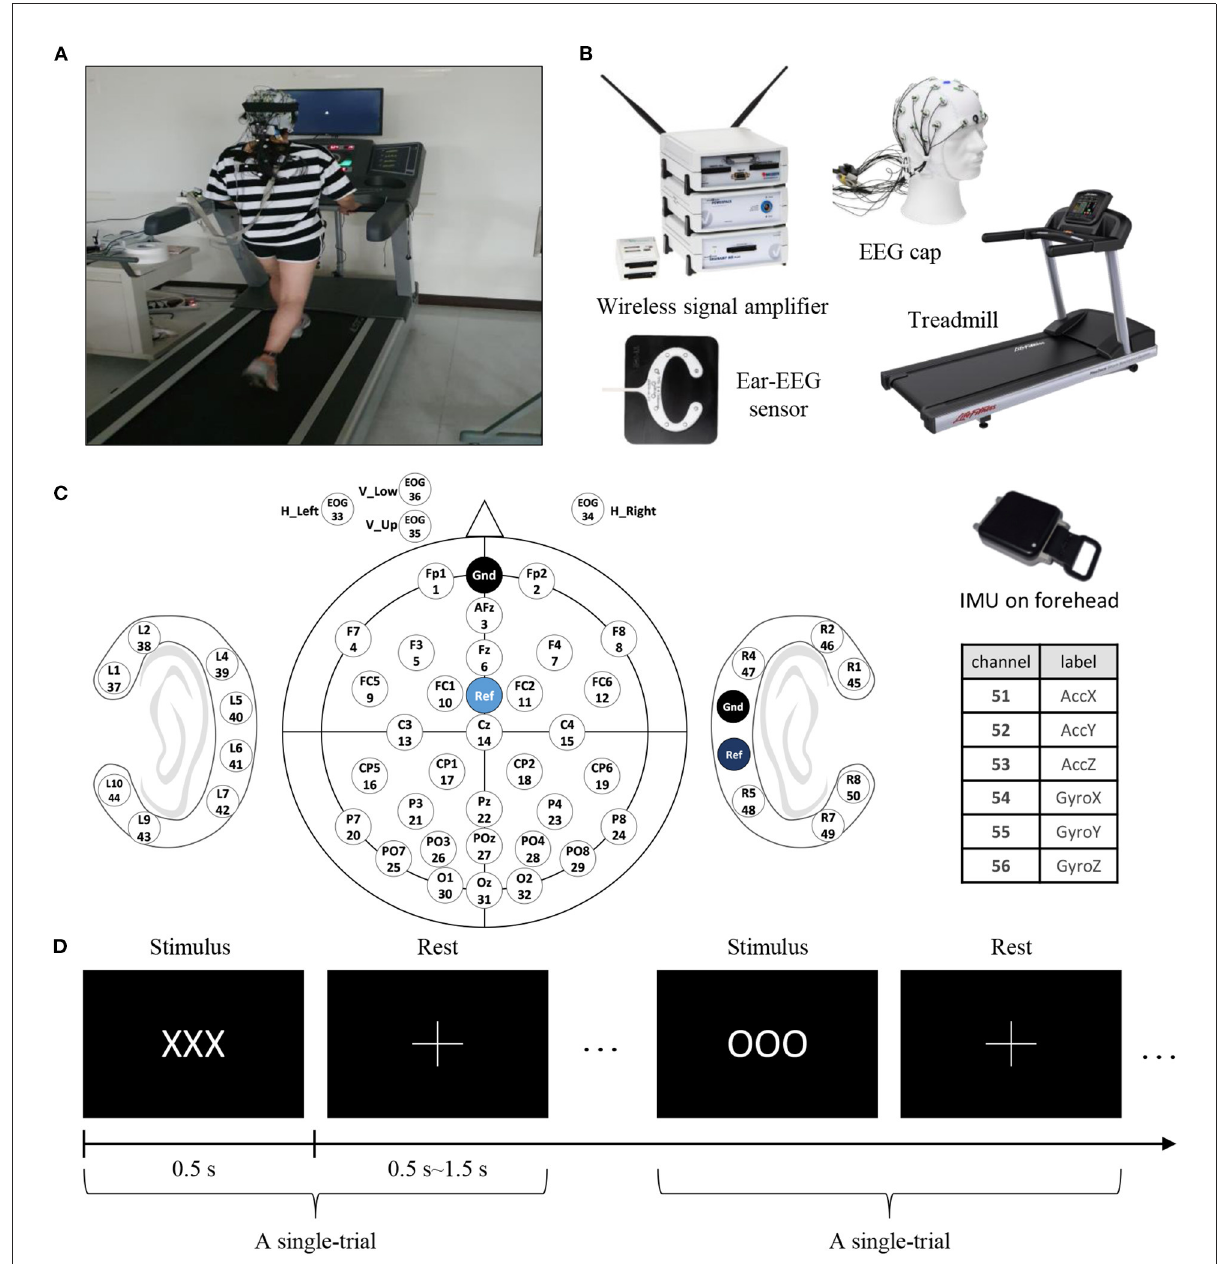
FIGURE11 Experimental setups and protocols. (A) Experimental setup showing a subject walking on a treadmill. (B) In this experiment, we simultaneously collected data from various devices: EEG signals from the scalp (actiCap, BrainProducts GmbH, Germany), EEG signals from around the ear (cEEGrid, TMSi, USA), forehead IMU signals (APDM, APDM wearable technologies, USA), and from the treadmill. (C) Channel labels: 32 scalp-EEG electrodes, 3 EOG electrodes, and 6 IMU sensors. (D) The experimental paradigm was executed with target (“OOO”) and non-target (“XXX”) characters. The ratio of targets was 0.2 and the number of total trials was 300. In a trial, a stimulus was presented for 0.5 s followed by the cross symbol indicating a random rest period lasting 0.5–1.5